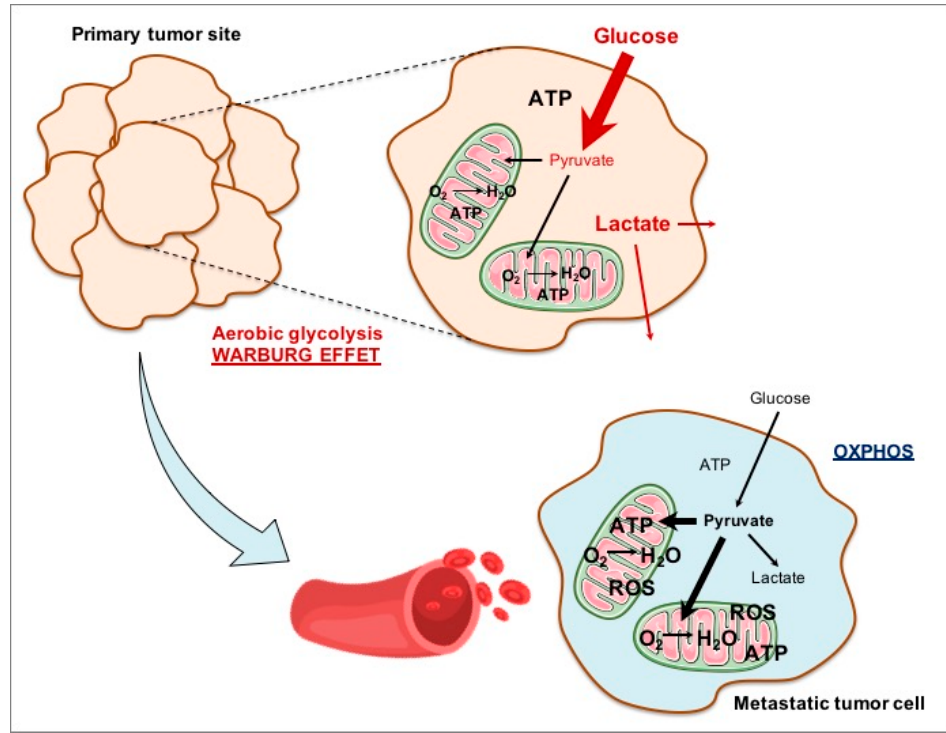
Figure 3. Tumor cell metabolism. In the primary tumor site, cancer cells mainly rely on aerobic glycolysis (Warburg effect) and this metabolism favors cell proliferation and tumor growth. Some cancer cells escape from the primary tumor site through the bloodstream, generating metastasis in other organs. It is thought that, to do this, some cancer cell types switch to a more oxidative metabolism.